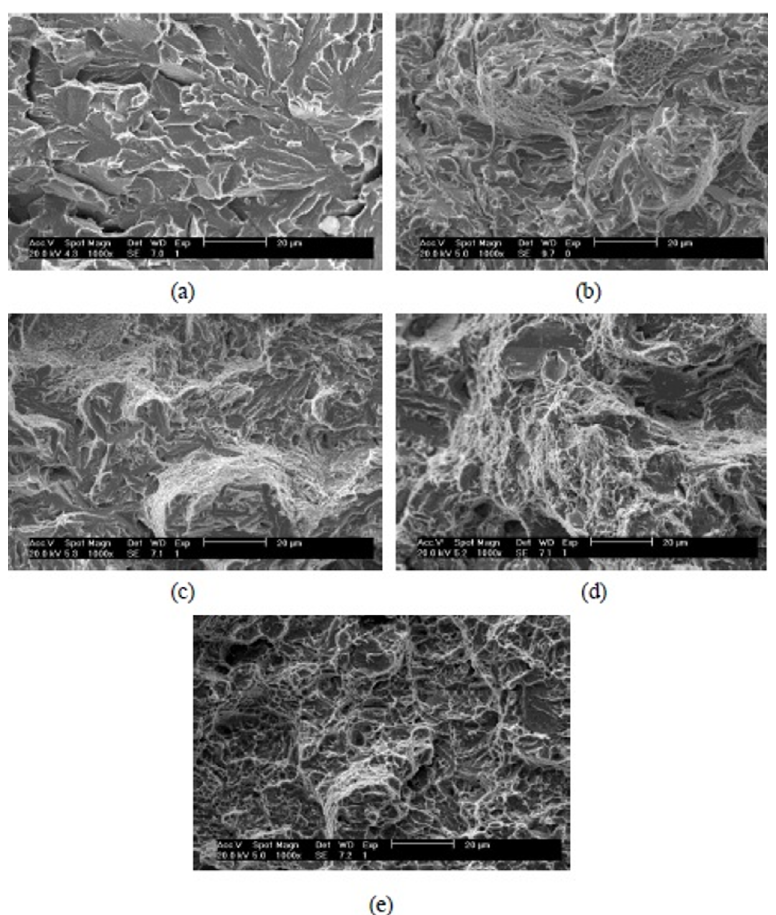
Figure 10. Scanning electron micrograph (SEM) of impact fracture surface showing (a) transgranular cleavage and quasi - cleavage in martensitic sample, (b) mostly quasi - cleavage and some dimple rupture in mixed 12% lower bainite - martensite microstructure, (c) quasi - cleavage and dimple rupture in mixed 28% lower bainite - martensite microstructure, (d) mostly dimple rupture and some quasi - cleavage facets in mixed 49% lower bainite - martensite, (e) dimple rupture in fully lower bainitic